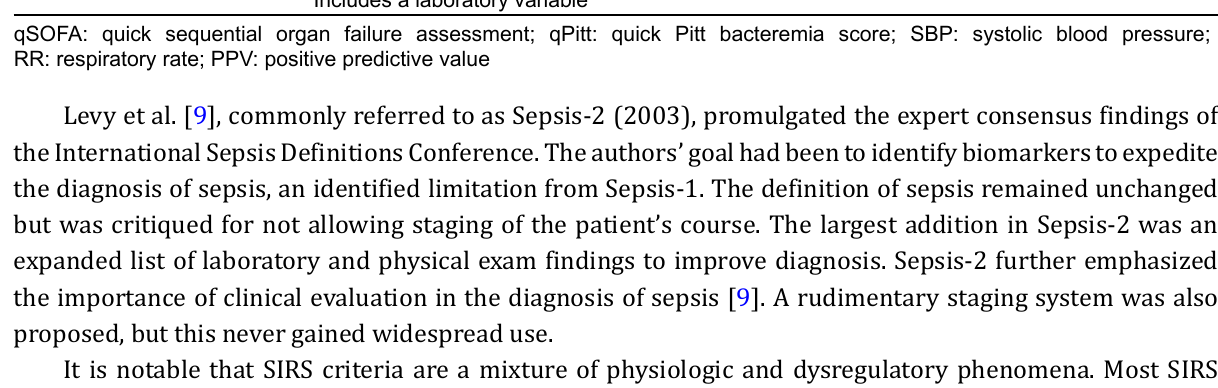
Table 1. Comparison between contemporary criteria for detection of systemic and life-threatening infections ( continued ) Characteristic/score SIRS qSOFA qPitt Cons Low specificity for infections Variable sensitivity and Not evaluated yet in patients with specificity based on population suspected infections Low PPV Non-discriminatory performance for mortality Includes a laboratory